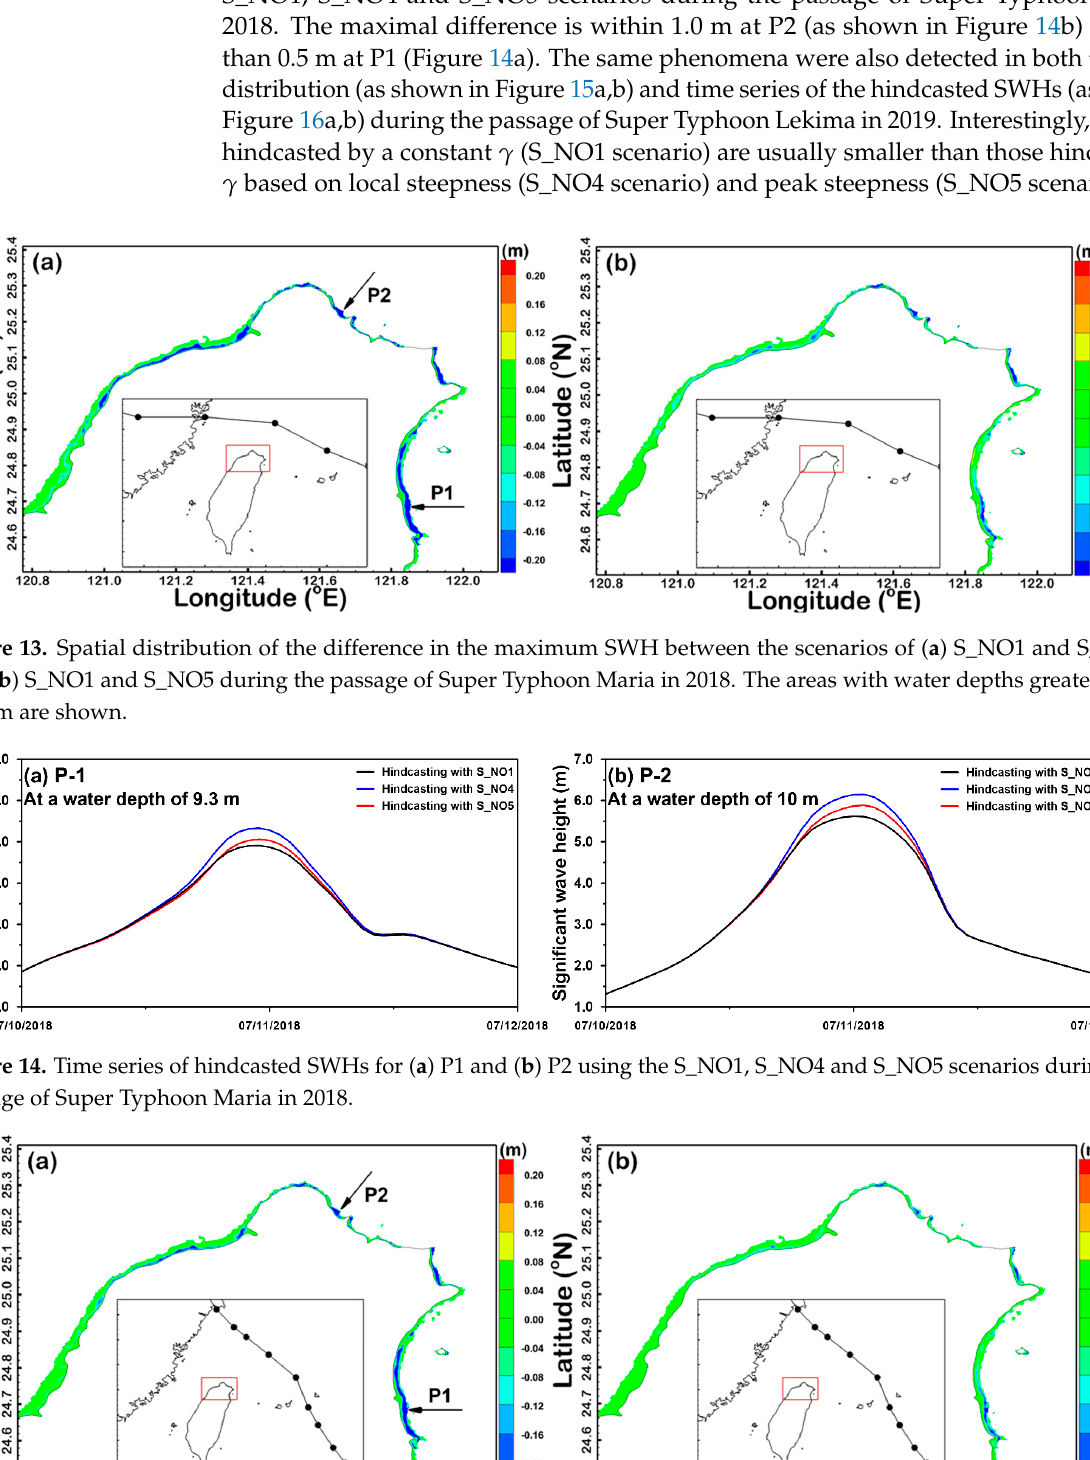
17 of 23 Figure 12. Time series of hindcasted SWHs for ( a ) P1 and ( b ) P2 using the S_NO1, S_NO2 and S_NO3 scenarios during the passage of Super Typhoon Lekima in 2019. 3.3. Effect of the Wave-Breaking Criterion on the Typhoon-Driven SWH Simulation in the Surf Zone Many parameterizations of the wave-breaking criterion have been implemented